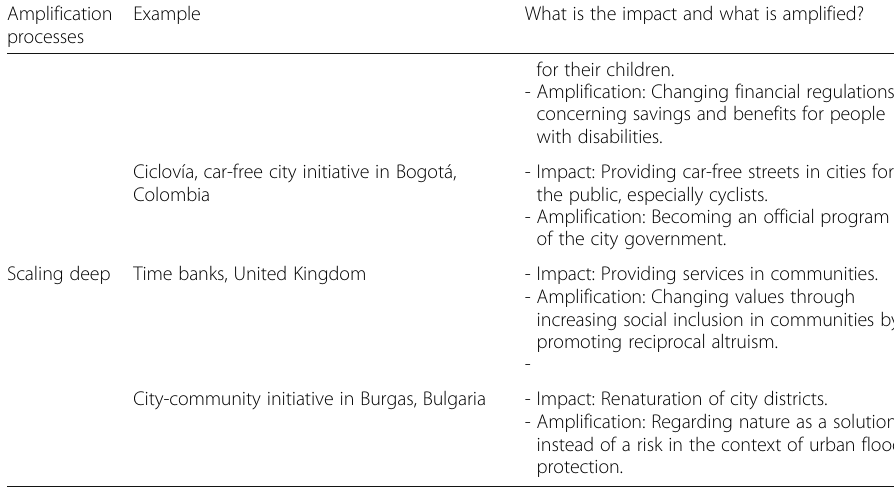
Table 4 Overview of examples that illustrate the amplification processes. For each example, we describe what the impact is and how it is amplified